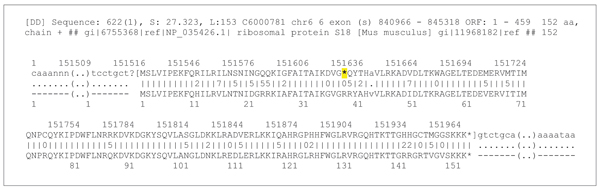
Pseudogene in ENm004 sequence, absent from HAVANA annotation. The alignment has a stop codon close to position 151636.